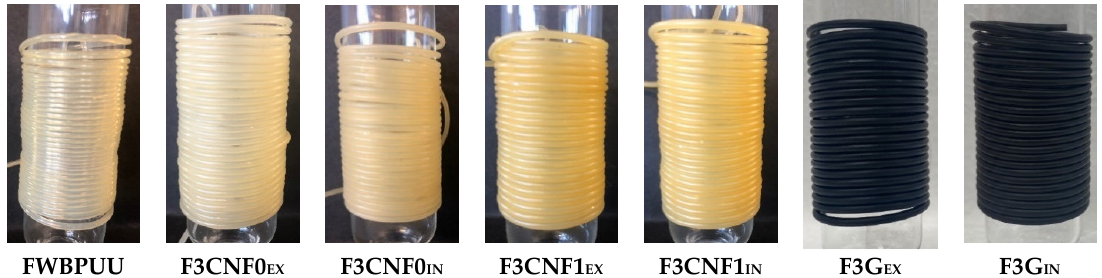
Figure 5. Photographs of the prepared in-situ and ex-situ filaments. Fourier transform infrared spectroscopy analyses were carried out in order to assess possible interactions taken place between the WBPUU matrix and the nanoreinforcements used. FTIR spectra of WBPUU filament and composite filaments are shown in Figure 6. FWBPUU spectrum shows characteristic bands of polyurethanes: an absorption band corresponding to H-bonding of polyurethanes’ N–H groups at 3360 cm −1 , a band attributed to carbonyl vibration of the polyol and urethane groups at 1730 cm −1 , bands at 1645 cm −1 and 1545 cm −1 , assigned to carbonyl stretching vibration of the urea groups, and C–N stretching vibration and N–H bending of urethane and urea groups, respectively, and bands in the 1250–1000 cm −1 region corresponding to C–O stretching vibrations [59–61]. When analyzing composite spectra, it can be observed that all systems show similar spectra with only slight differences in the N–H band. For composites containing cellulose nanofibers, this band displaced to lower wavenumbers, indicating H-bonding taking place between the polyurethanes and cellulose molecules. This change took place for all WBPUU/CNF composites. However, no differences were observed based on the type of cellulose employed or the incorporation route. Composites containing G presented a change in wavenumber, however, in this case the band displaced to slightly higher wave- number values. This change could be due to an overlapping of the matrix N–H band with the O–H band of G and E.